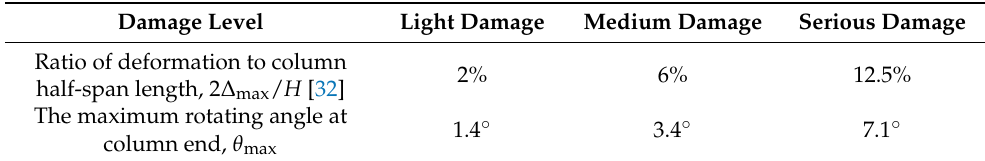
Table 4. Bending damage criteria.